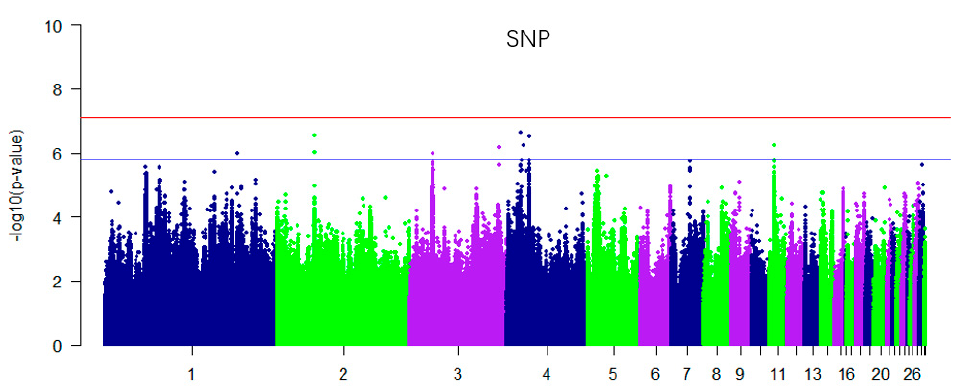
Figure 2. Manhattan plot derived from a genome-wide association studies (GWAS) single nucleotide polymorphisms (SNPs) at muscle glycogen. Each dot corresponds to a SNP within the dataset, while the horizontal blue and red lines denote the genome-wide significance (7.15 × 10 − 8 ) and suggestive significance thresholds (1.43 × 10 − 6 ), respectively. The Manhattan plot contains –log 10 observed p -values for genome-wide SNPs (y-axis) plotted against their corresponding position on each chromosome (x-axis) . Table 1. SNPs with genome-wide significance for muscle glycogen.